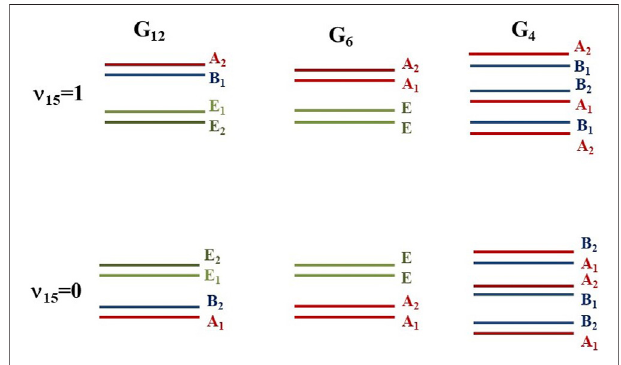
FIGURE 4 | Subcomponents of the (0 0 0) and (0 01) energy